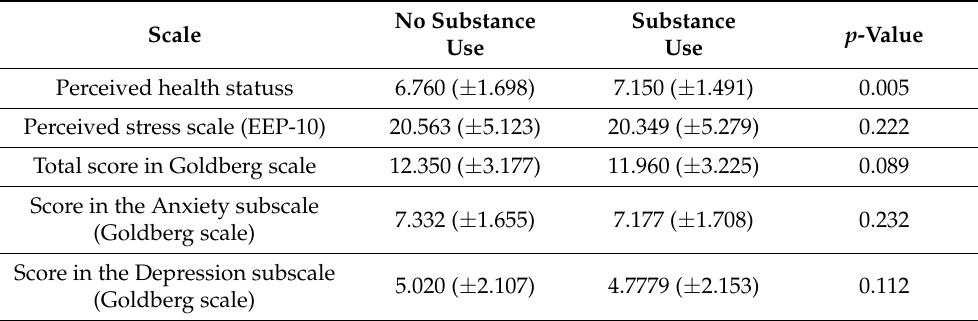
Table 5. Mean score on the perceived health status scales, perceived stress scale and anxiety and depression scale according to